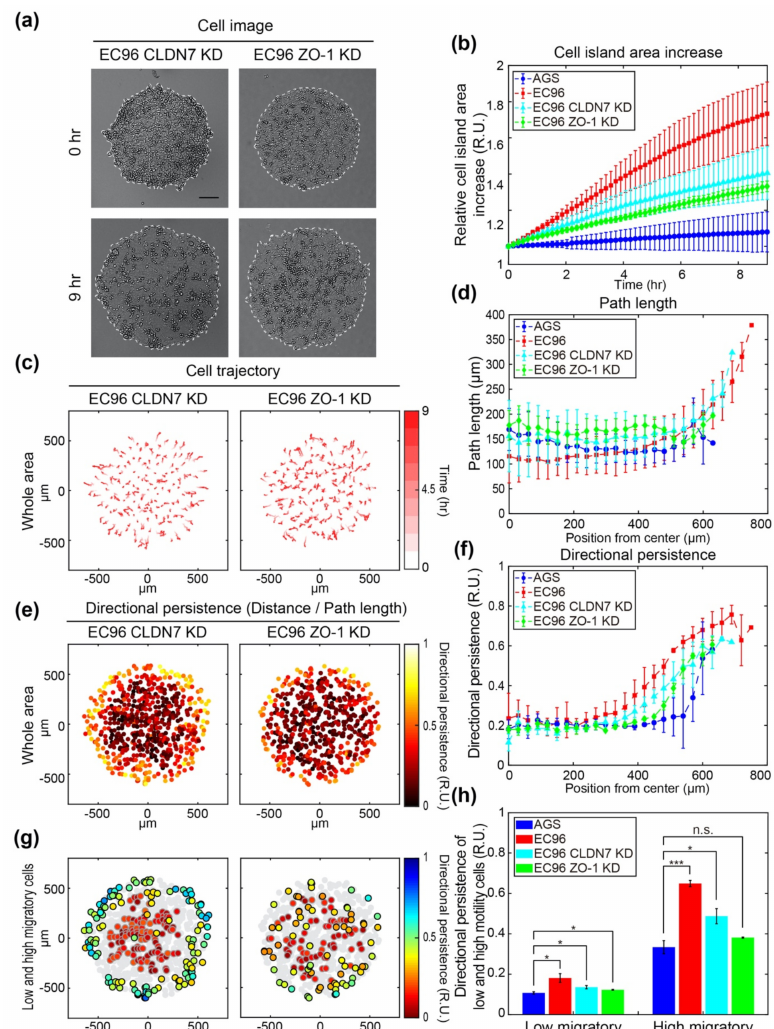
Figure 4. Analysis of motility and directionality of cell islands composed of tight junction protein knockdown cell lines and comparison with AGS and EC96. ( a ) Bright-field images of CLDN7 and ZO-1 KD cell islands at 0 h and 9 h after release (scale bar = 200 µ m). ( b ) Relative area increase of cell islands composed of the AGS (blue circle), EC96 (red square), CLDN7 KD (cyan triangle), and ZO-1 KD (green diamond) cells over time. The error bars represent the standard deviations calculated from separate assays on each group ( n = 5). ( c ) The trajectory of the cells within the CLDN7 KD and ZO-1 KD cell islands. The stronger red color of the arrows indicates more time passed. ( d ) Average path length along the same distance from center to edge of the AGS (blue circle), EC96 (red square), CLDN7 KD (cyan triangle), and ZO-1 KD (green diamond) cell islands. The error bars represent the standard deviations calculated from separate assays on each group ( n = 5). ( e ) Color-code map of the directional persistence of the cells within the CLDN7 KD and ZO-1 KD cell islands. The brighter dots indicate higher directional persistence. ( f ) Average directional persistence along the same distance from center to edge of the AGS (blue circle), EC96 (red square), CLDN7 KD (cyan triangle), and ZO-1 KD (green diamond) cell islands. The error bars represent the standard deviations calculated from separate assays on each group ( n = 5). ( g ) Color-code map of the directional persistence of the low 25% (gray edge circles) and high 25% (black edge circles) of motile cells within the CLDN7 KD and ZO-1 KD cell islands. Gray circles represent mid-quartile (25–75%) motile cells within each group population. ( h ) Average directional persistence of low and high motility cells within the AGS (blue), EC96 (red), CLDN7 KD (cyan), and ZO-1 KD (green) cell islands. The error bars represent the standard errors calculated from separate assays on each group (n.s. not significant, * p < 0.05 and *** p < 0.001; n =